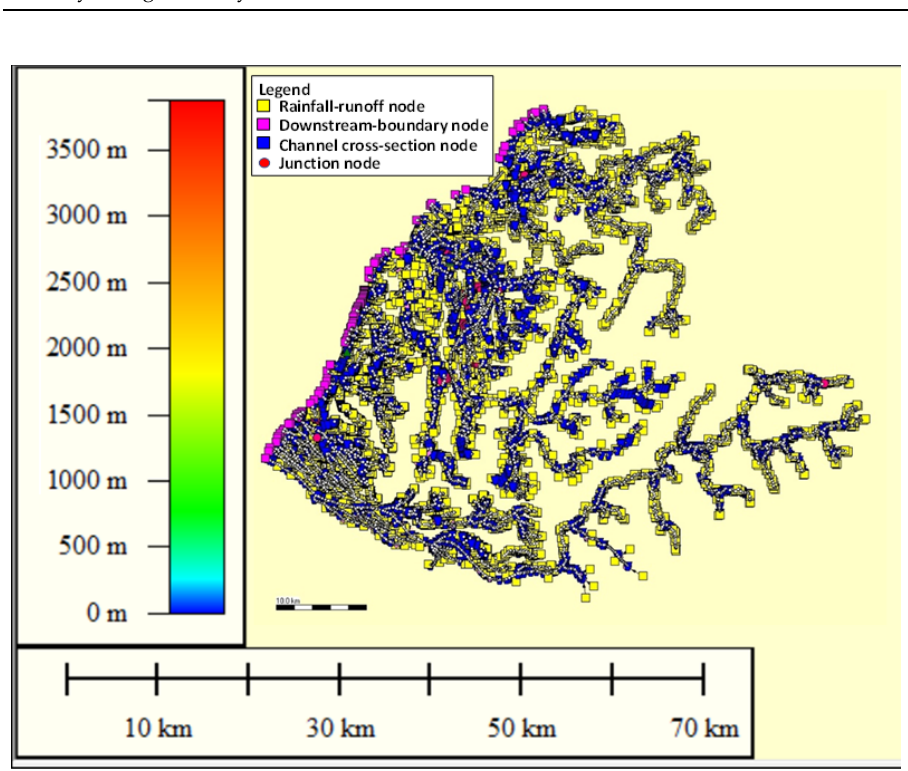
Figure 9. 2D SOBEK model for Miaoli County.